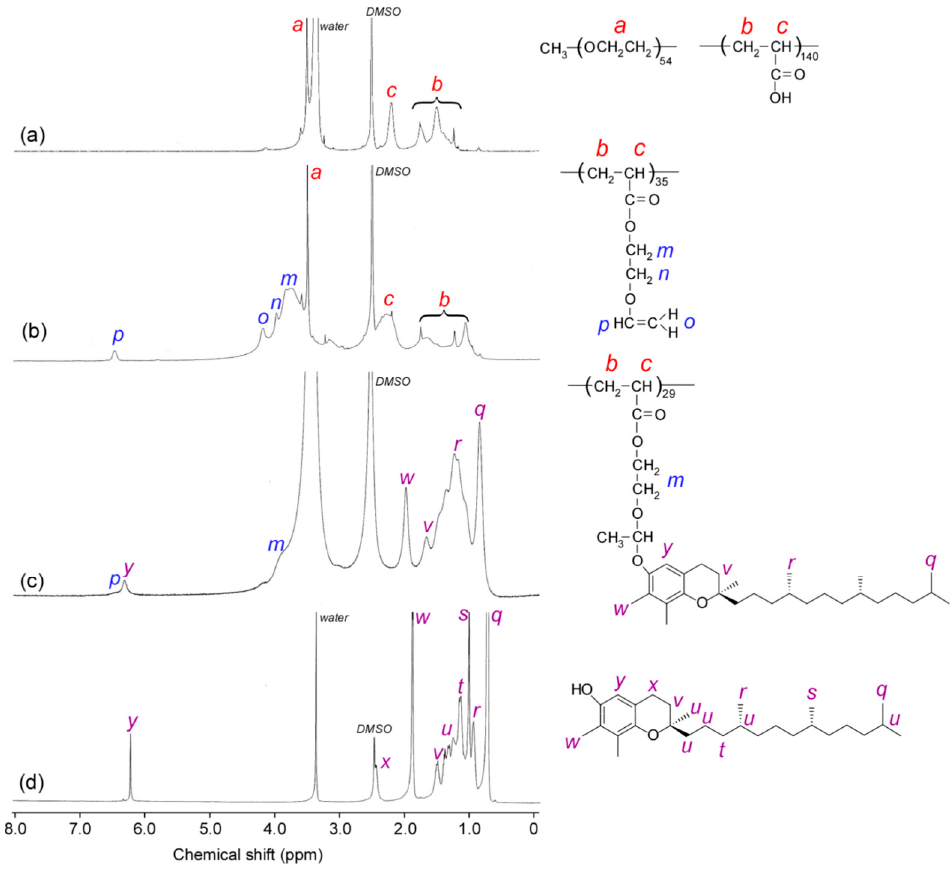
Figure 3. 1 H NMR spectra of ( a ) PEG 54 -PAA 140 , ( b ) PEG 54 -P(AA/VE35) 140 , ( c ) PEG 54 - P(AA/VE6/ γ TCP29) 140 , and ( d ) γ TCP in DMSO- d 6 .